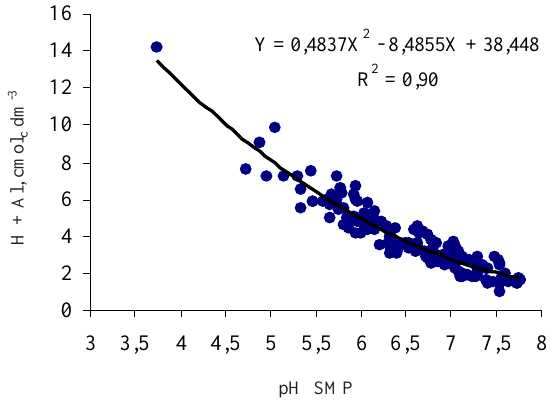
Figura 3. Relação entre pH SMP e teores de H +